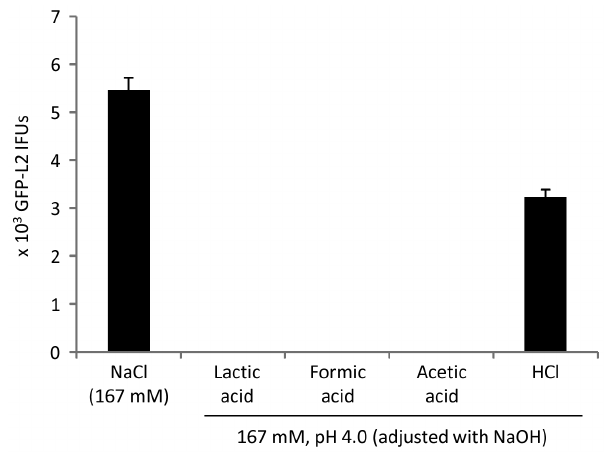
Figure 9. Full inactivation of GFP-L2 by formic acid and acetic acid but not pH-adjusted HCl. Experiments were carried in the same manner as those in Fig. 3 except acid solutions used to treat EBs were prepared in H 2 O.